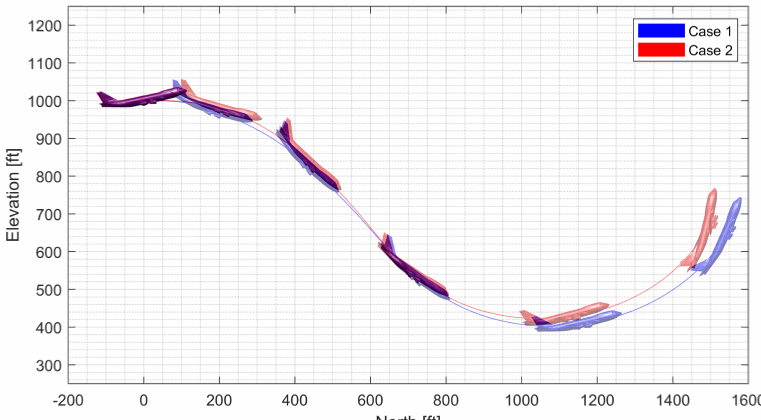
Figure 12. Flight trajectory of the push-over and pull-up ( H ∞ ).